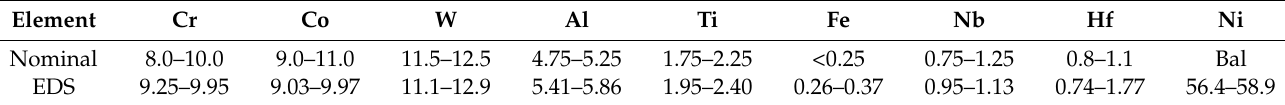
Table 1. Mass fraction of main elements of DZ22B alloy (wt.%).